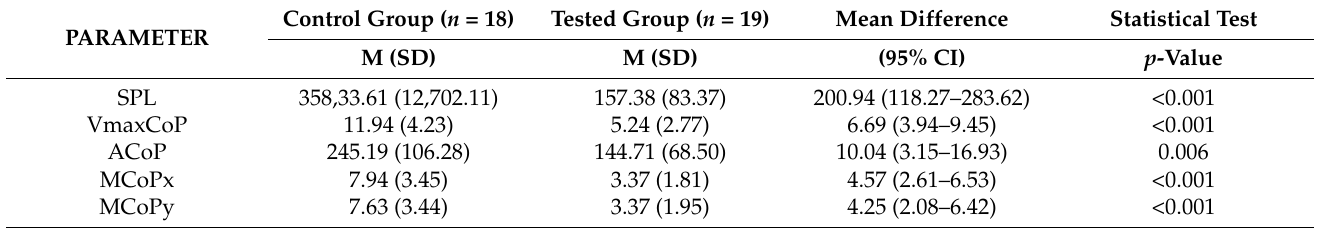
Table 3. Main center-of-pressure (CoP) parameters describing spontaneous sway of CoP in the supine position in the control group (infants presented normal fidgety movements) vs. the tested group (infants presented absent fidgety